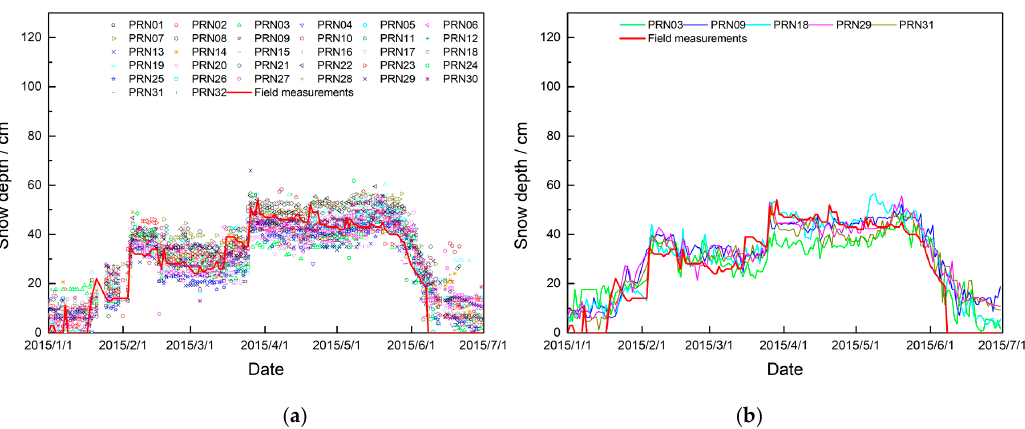
Figure 7. Scatterplot ( a ) and line plot ( b ) of individual satellite-derived snow depths versus in-situ snow depths in 2015. Red lines represent the measured snow depths from field work. Scatterplot of all individual satellites is more beneficial to show the dispersion of individual satellite-derived snow depths in one day, while line plot of selected individual satellites better highlights the trends of individual satellite-derived snow depths.